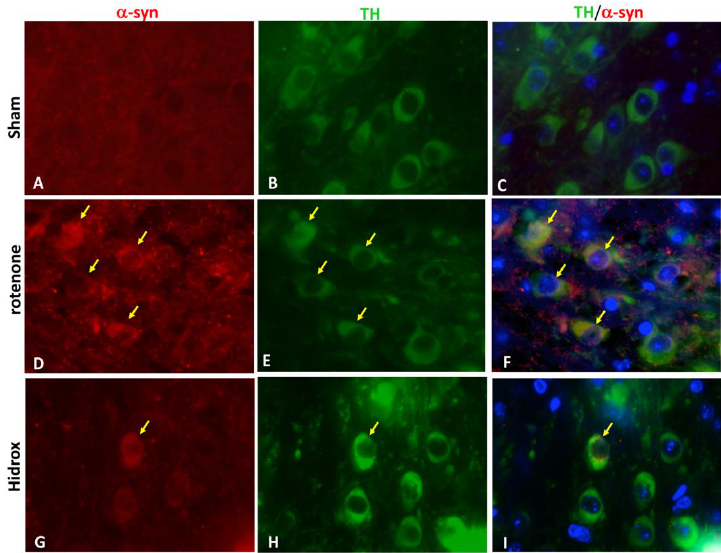
Figure 3. Effects of HD on -synuclein expression and a double staining of TH/α–synuclein after rotenone-intoxication. Results are shown for Sham ( A – C ), mice after rotenone-intoxication ( D – F ) and mice treated with HD ( G – I ). Midbrain sections were double stained with antibodies against TH ( B , E , H— green)/α-syn ( A , D , G— red). Midbrain sections revealed an important expression of α-syn in dopaminergic neurons in the rotenone group ( F ), compared with Sham group ( C ). TH/α-syn, double stained, was decreased after HD treatment ( I ). The photographs are illustrative of at least three experiments performed on different days, and are representative of all animals in every group (N = 5 mice/group). Images were digitalized at a resolution of 8 bits into an array of 2048 × 2048 pixels. Scale bar: 100 μm.